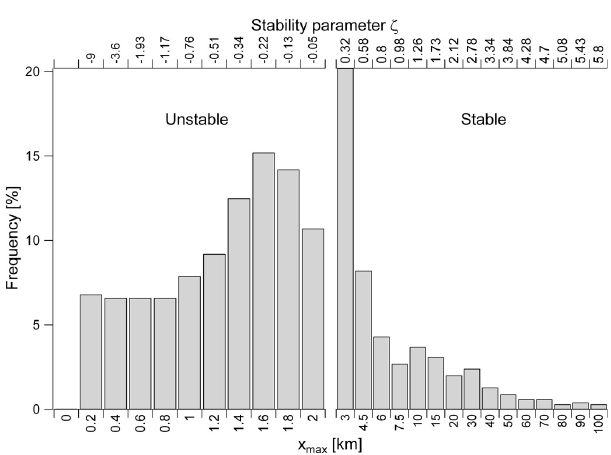
Fig. 1. Frequency distributions of unstable ( ζ < − 0 . 05), near- neutral ( − 0 . 05 ≤ ζ ≤ 0 . 32 ) and stable ( ζ > 0 . 32) stability condi- tions at the measurement height by time of day and season (a) win- ter (b) spring (c) summer (d) autumn (see Table 1 for definitions).